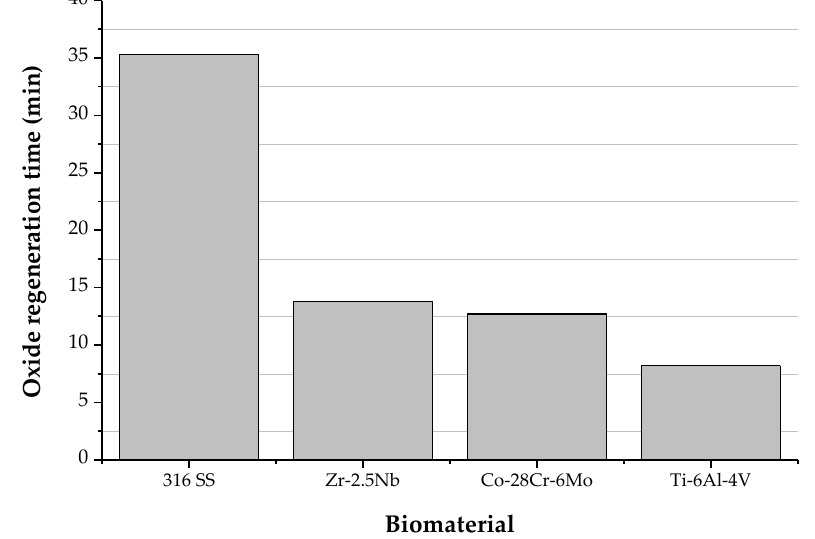
Figure 9. Regeneration time of surface oxide films on biomaterials. Drawn based on values from Hanawa